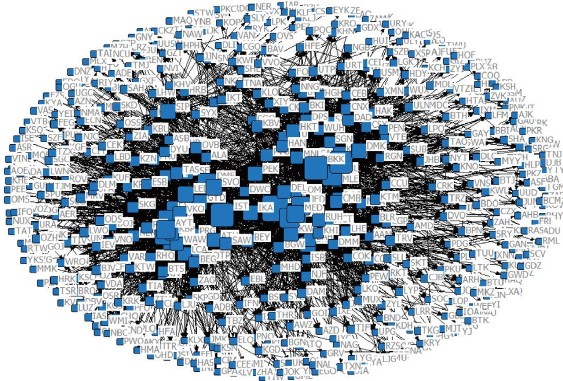
Figure 1: Schematic diagram of the “Belt and Road” aviation network.